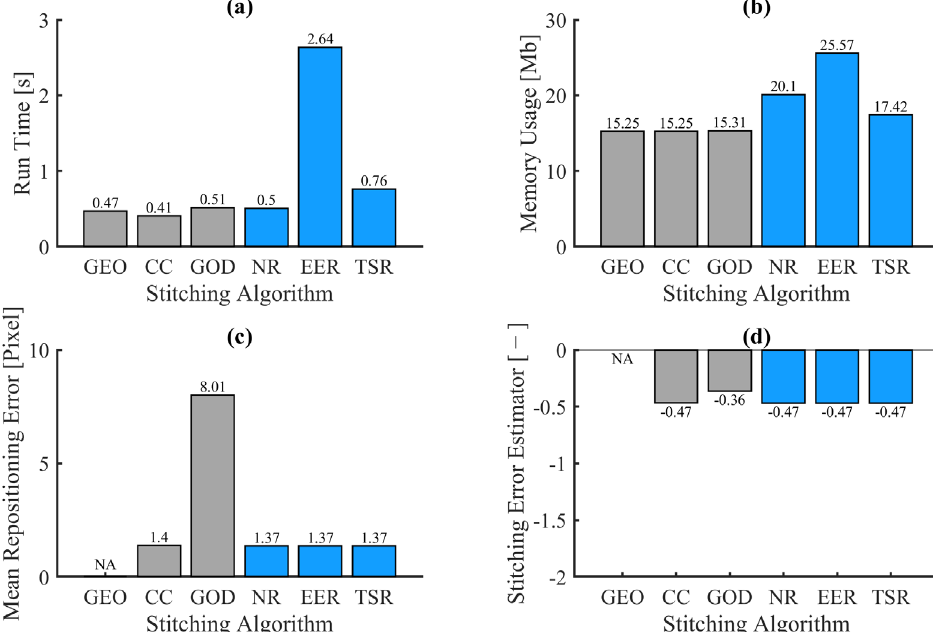
Figure 9. Bar charts of the quantitative criteria for test case A: run time ( a ), memory usage ( b ), mean repositioning error ( c ) and stitching error estimator ( d ). NA = Non Applicable.